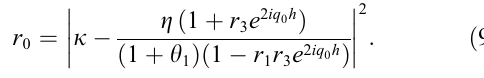
Figure 4. Dependence of phase shift on the wavelength for different slit width a and spacer thickness t : (a) t = 0.1 mm, and a = 1.0 or 0.3 mm; (b) a = 1.0 mm, and t = 0.1 or 0.3 mm. Here d = 20 mm. The correspondence between the phase shift u 3 (the line) and l ( m = 0, 1, 2) are shown in (c), where d = 20 mm, a = 0.5 mm, and t = 0.2 mm. The inset of (c) shows the zero-phase point A (the circles) as a function of lattice period d (where we fix a = 1.0 mm and t = 0.2 mm), which track the position of HFP mode in the spacer closely (the